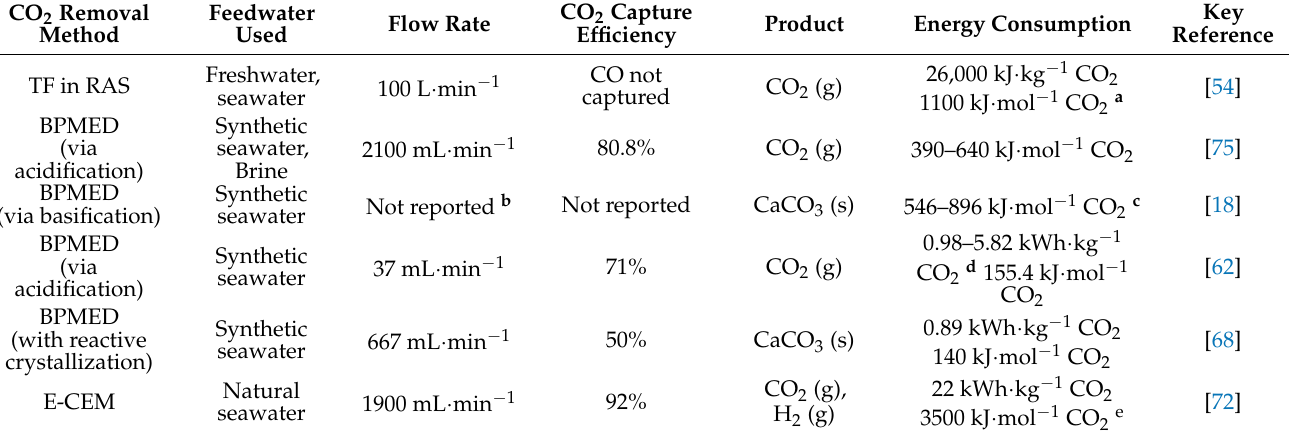
Table 1. Summary of technologies for seawater deacidification by CO 2 removal.